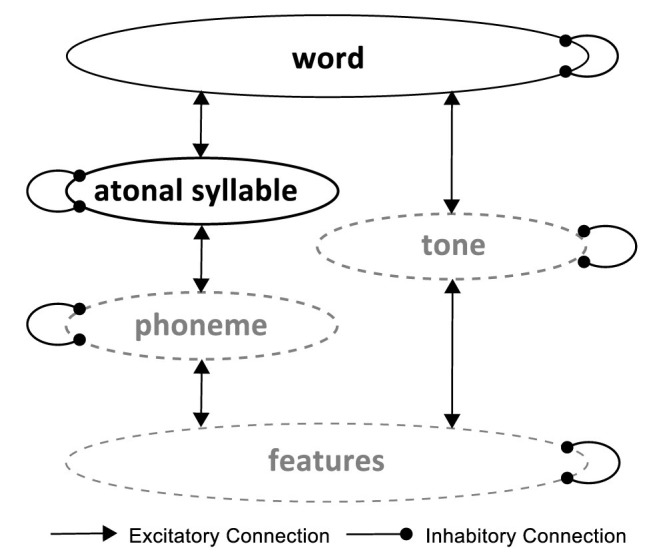
The Reverse Accessing Model (RAM) for sub-lexical phonological processing of tonal speech. Each eclipse indicates a level of processing devoted to a specific type of phonological representation. The solid lines indicate ready access to the extracted information, while the dotted lines mark “hidden” information that can only be accessed by reactivating the system with the perceived word. Information accessing starts from the top and proceeds to the lower level if necessary.